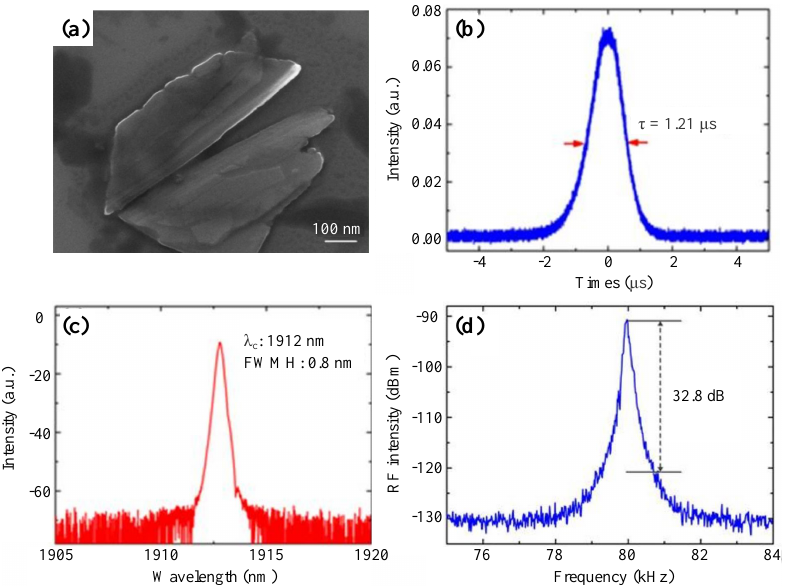
Figure 10. The experimental results of Q-switched YDFL enabled by WS 2 SA. ( a ) SEM image of WS 2 nanoplates. ( b ) Output spectrum, ( c ) single pulse profile, and ( d ) radio frequency (RF) spectrum at the repetition rate of 81.5 kHz. ( a – d ) adapted from